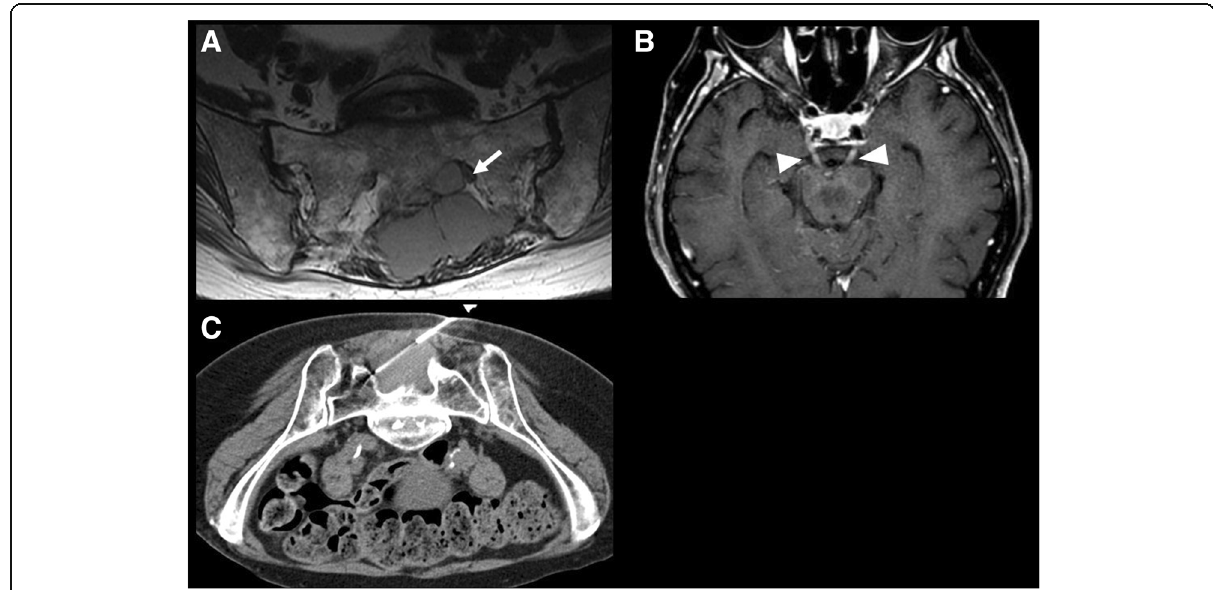
Fig. 7 A 84-year-old woman with history of nodal marginal zone lymphoma treated with cyclophosphamide, hydroxydaunorubicin, oncovin, and prednisone, presenting with new onset back pain and acute diplopia. a T2-weighted axial image showed a large mildly hyperintense mass in the sacrum extending to the left sacral ala and into the left S1 foramen (arrow). b Axial T1-weighted images of the brain showed diffuse enhancement of the bilateral III cranial nerves (arrowheads). c CT-guided biopsy of the sacral mass demonstrated histologic transformation to diffuse large B cell